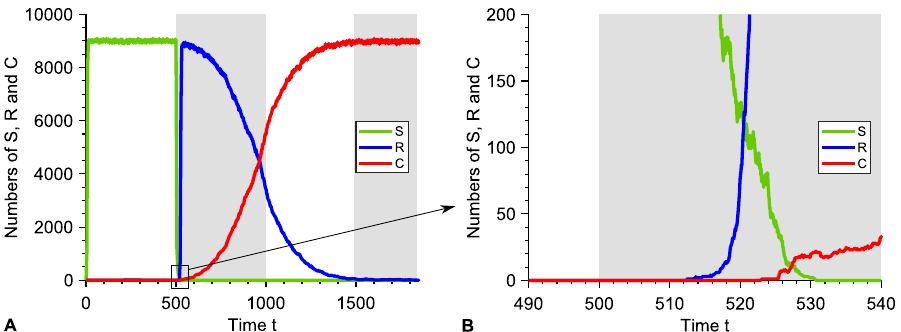
Fig 3. Resistance emergence in the presence of a biocidal antimicrobial above the MIC. A: Numbers of sensitive (S), resistant (R) and compensated (C) microorganisms versus time in an example simulation run for K = 10 4 , with T = 1000. Here resistance takes over. Phases without (resp. with) antimicrobial are shaded in white (resp. gray). B: Zoom showing the emergence of resistance in this realization: an R mutant appears after antimicrobial is added (gray). At this time, the S population is decreasing due to the antimicrobial-induced high death rate, but the surviving S microorganisms are still able to divide. Parameter values and initial conditions are the same as in Fig 2A, 2B and